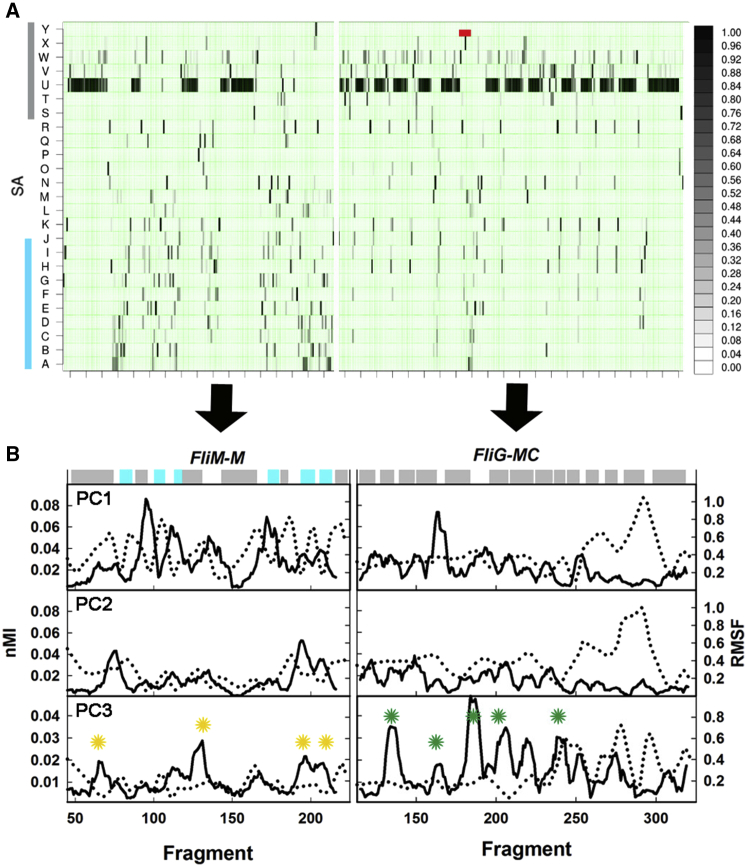
Hinge Elements for the PC Motions(A) SA representation of ensemble fluctuations. SA letters readout of secondary structure (α helix [gray bar], β sheet [blue bar]) as detailed (Figure S2). Red bar denotes grafted PDB: 1LKV helixMC segment. Grayscale bar (black, high; white, low) denotes populated ensemble fraction.(B) Superimposed nMIPC (black lines) and RMSF (dotted lines) profiles for PDB: 4FHR. Horizontal bar, colors as in (A), shows secondary structure profile. Peaks that represent hinges for the PC3 rotation in FliMM (yellow asterisks) and FliGMC (green asterisks) are marked. For FliMM RMSF-nMIPC1 Pcorr = −0.17, RMSF-nMIPC3 Pcorr = −0.2, nMIPC1-nMIPC3 Pcorr = 0.27. For FliGMC, RMSF-nMIPC1 Pcorr = −0.36, RMSF-nMIPC3 Pcorr = −0.21, nMIPC1-nMIPC3 Pcorr = 0.21.See also Figure S2.